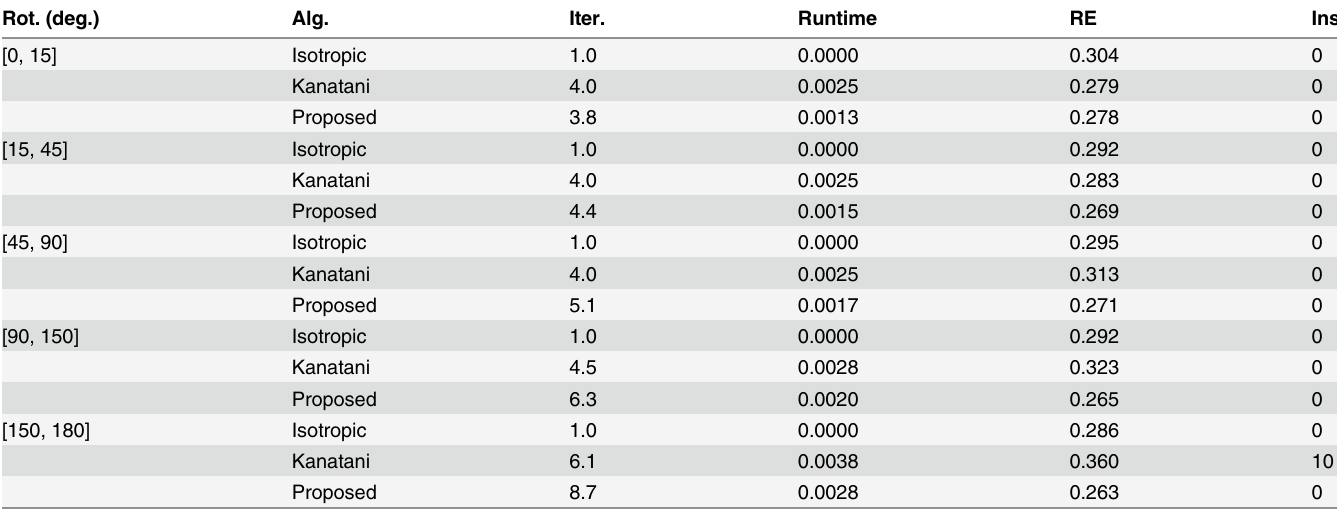
Table 3. Rotation-only registration results for corresponding point sets with anisotropic noise present in both sets of points. (Experiment 1C). Rot.